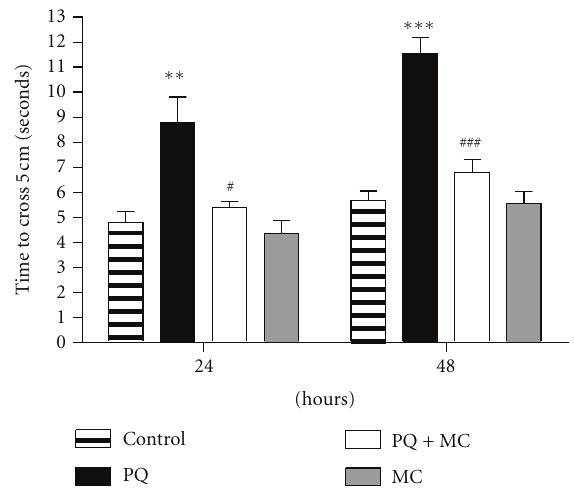
Figure 2: MC protects against PQ-induced mobility defects. The time required for adult male flies to climb 5cm, after 24 and 48 hr of exposure to 10 mM PQ or 10 mM PQ with 1mM MC flies was assayed. The ingestion of 1mM MC alone has no e ff ect on mobility, while ingestion of PQ alone adversely a ff ects mobility. PQ and MC co-feeding results in mobility performance near control levels. The ∗ and # indicate the significance of di ff erences between control and PQ-fed flies and between PQ only and co-fed flies, respectively. ∗∗∗ / ### indicate P < 0 . 001, ∗∗ indicates P < 0 . 005, and # = P < 0 . 05. Error bars represent standard error of the mean. Each data point represents at least 15 replications of 10 flies